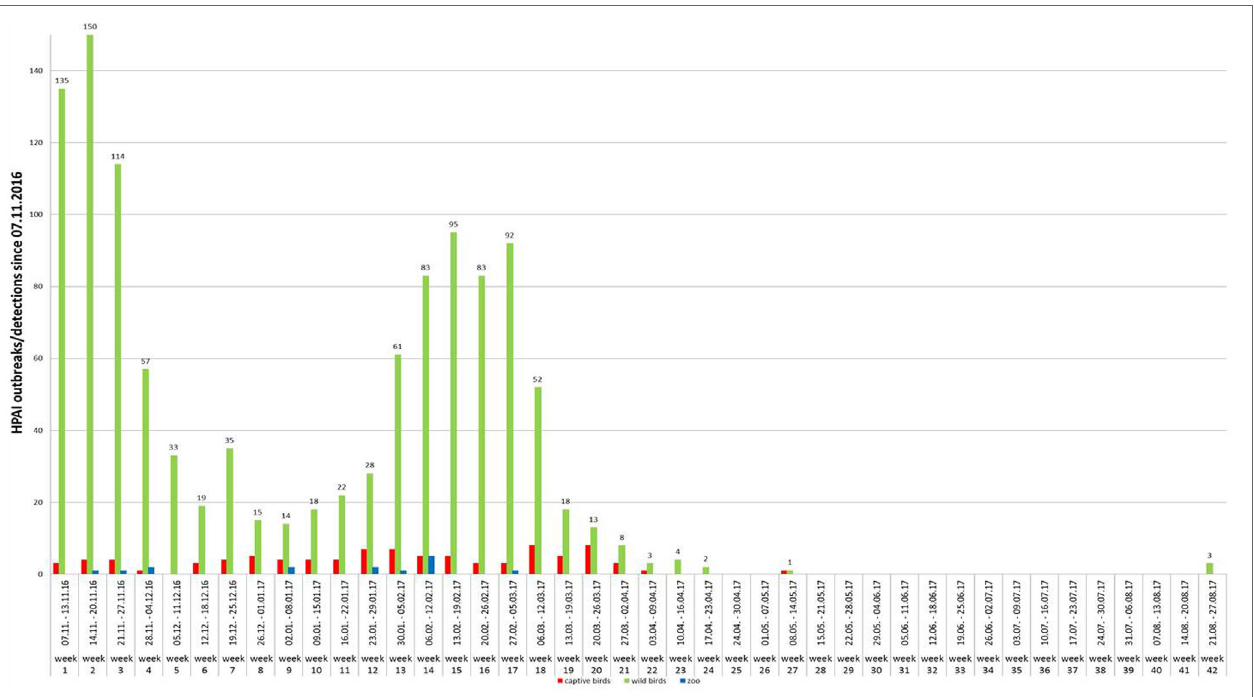
FigUre 4 | Weekly number of outbreaks of highly pathogenic avian influenza in poultry (red columns), zoos (blue columns) and cases in wild birds (green columns) in Germany (November 2016–August